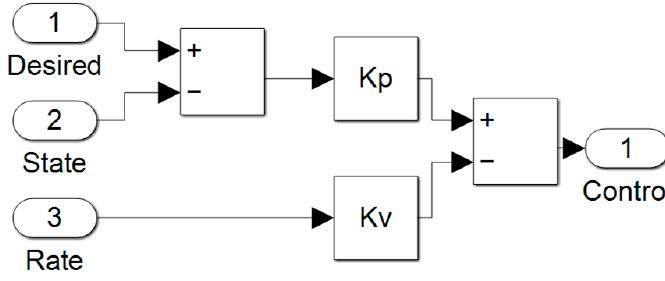
Figure A4. P+V controller topology.